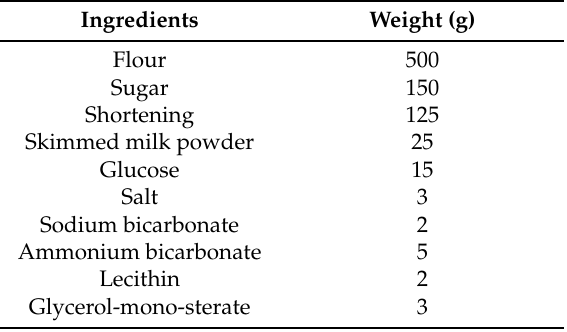
Table 1. Weight of ingredients used in biscuits preparation.